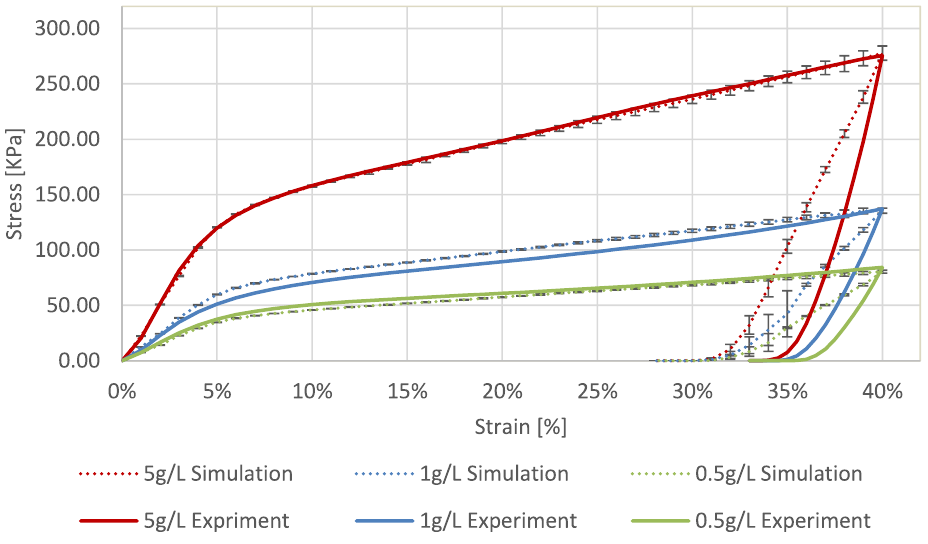
Figure 5. Comparison between experimental and simulation results.